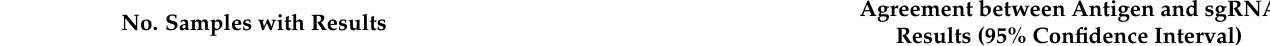
Table 2. Comparison of SARS-CoV-2 antigen and sgRNA results for NPS samples tested at indicated day(s) from symptom onset a